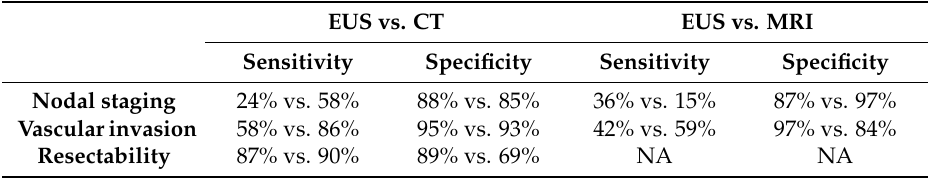
Table 1. Comparison of endoscopic ultrasonography (EUS) and either computed tomography (CT) or magnetic resonance imaging (MRI) scans for pancreatic